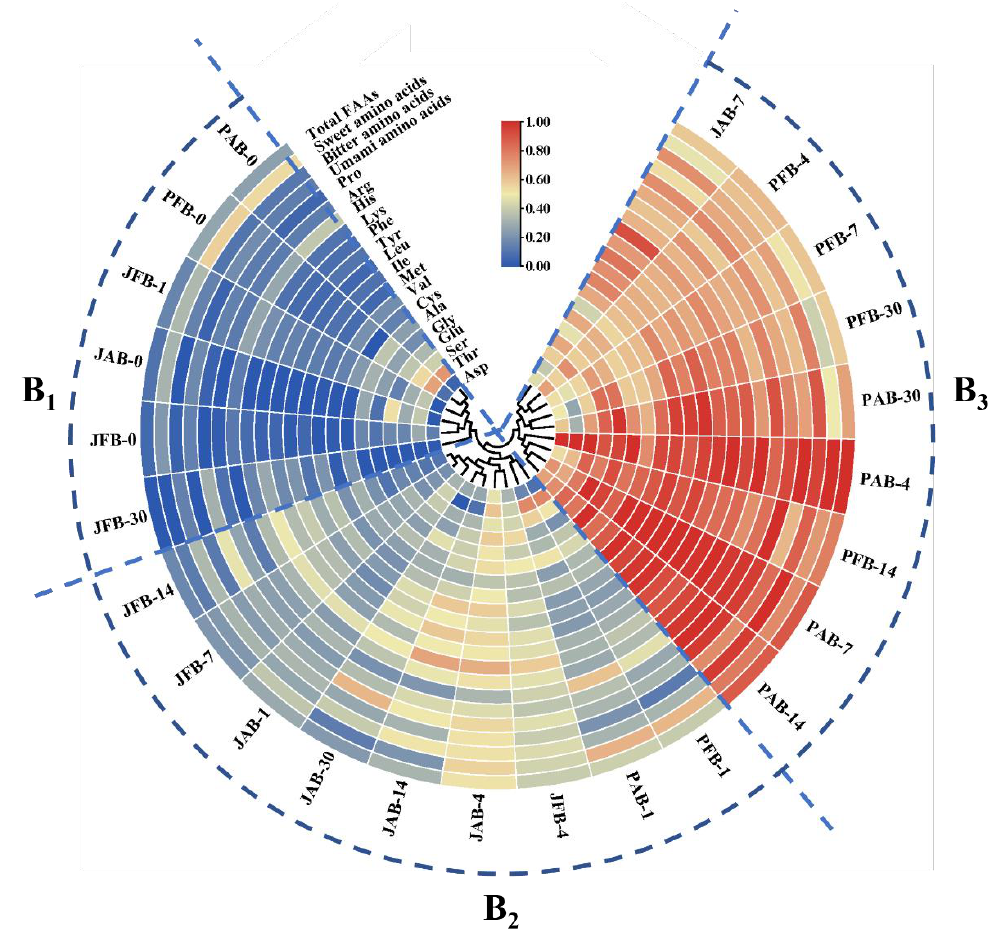
Figure 3. Heatmap visualization of free amino acids of pickled chili pepper processed by PFB, PAB, JFB, and JAB ( n = 3). The color intensity was based on a normalized scale from a maximum of 1 (red) to a minimum of 0 (blue), which indicated the abundance of the free amino acids among high (B 3 ), medium (B 2 ), and low (B 1 ).